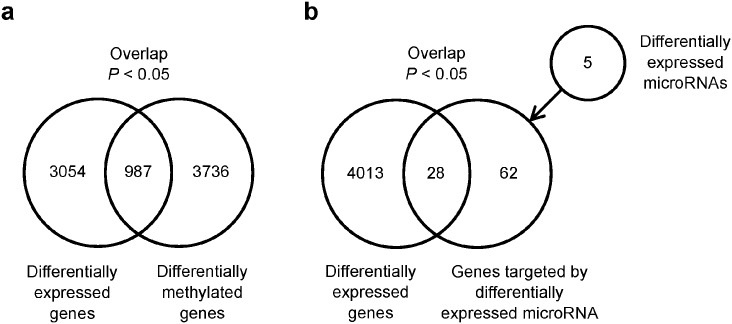
Relationship among differentially expressed genes, differentially methylated genes, and differentially expressed miRNAs between reMAITs and immature T cells.(a) Venn diagram showing differentially expressed genes and differentially methylated genes (limma, P < 0.05). (b) Venn diagram showing differentially expressed genes and those targeted by differentially expressed miRNAs (limma, P < 0.05). In (a) and (b), the overlap between the two groups is significant (Fisher’s exact test, P < 0.05).